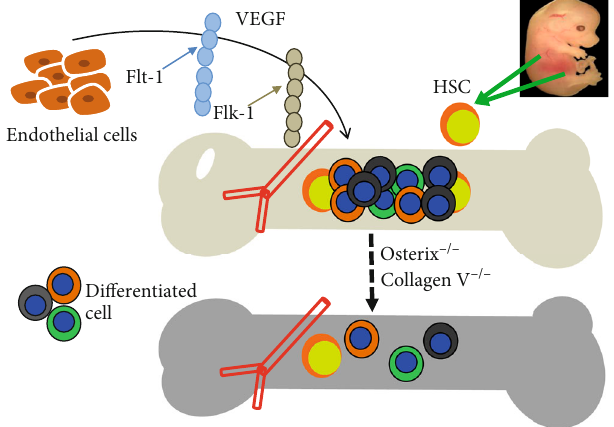
Figure 3: Endochondral ossi fi cation and vessel formation are required for lodgment of fetal liver HSC into the fetal bone marrow. Consistent levels of VEGF bene fi t vascularization in the fetal bone via binding with Flt-1 and Flk-1 receptors in endothelial cells. Vascularization in the fetal bone provides nutrition and aid niche formation. Loss of Osterix and collagen X negatively a ff ects fetal liver HSC mobilization into the bone marrow through disrupting endochondral ossi fi